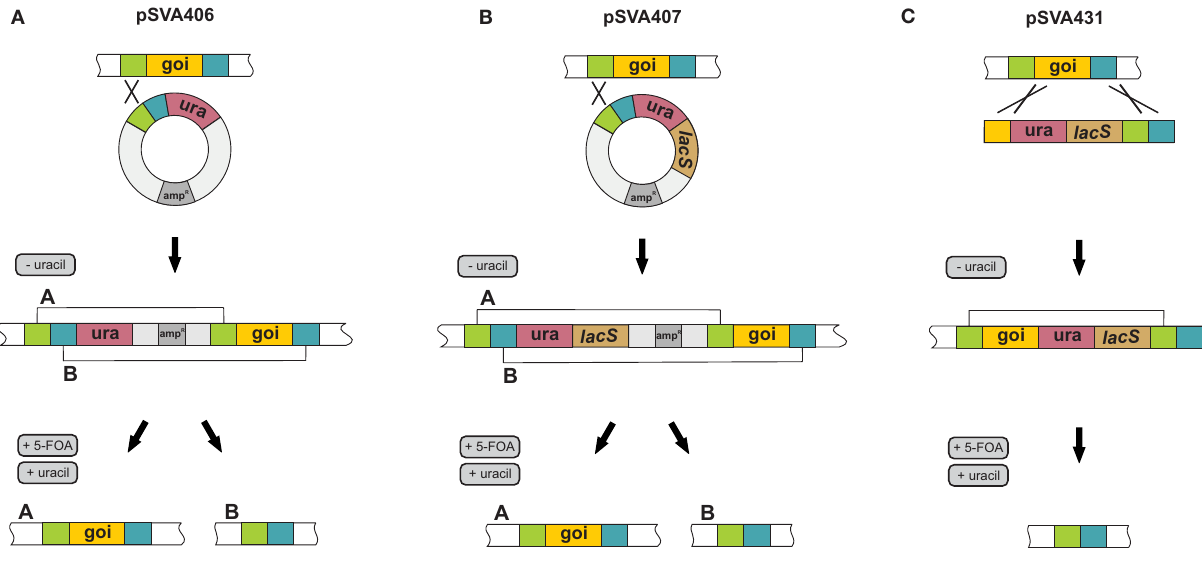
FIGURE 2 | Depiction of the different methods to obtain markerless in-frame mutants. (A) Plasmid pSVA406 integrates via single crossover into the genome and by addition of 5-FOA it can be selected for a second single crossover event that leads either to the wild type situation or the aimed add deletion mutant. (B) By using pSVA407 deletion mutants can be obtained via the same method as employed by pSVA406, only that pSVA407 contains the lacS gene in the selection cassette that allows for the easy identification of